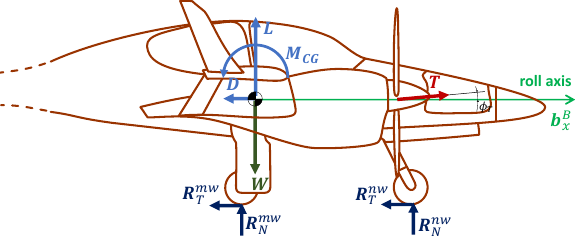
Figure 3. Forces and moment acting on the aircraft (positive as